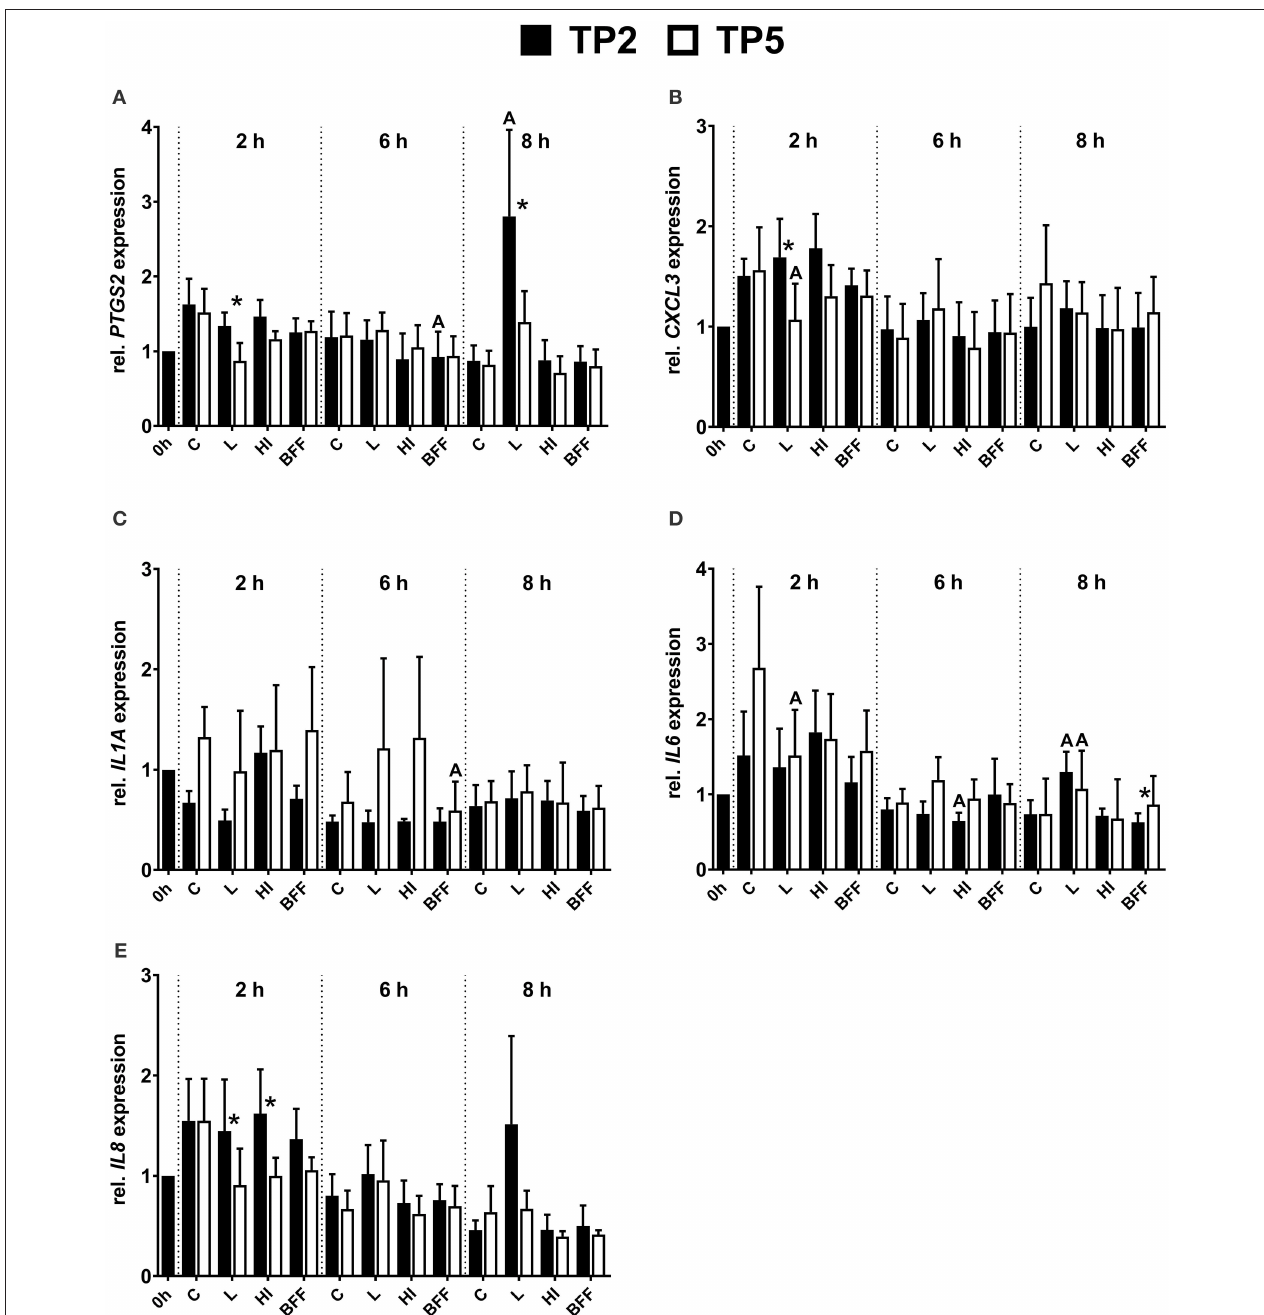
FIGURE 5 | Relative mRNA expression of (A) PTGS2 , (B) CXCL3 , (C) IL1A , (D) IL6 , and (E) IL8 in bovine endometrial epithelial cells co-cultured with TP2 or TP5 at MOI = 1 up to 8 h in the form of live (L), heat-inactivated (HI), or bacteria-free filtrate (BFF). The bars show means ± SEM of mRNA expression values from different cultures ( n = 5 cows). The letters above the bars indicate significantly different mRNA expression ( P < 0.05) compared with the control (C; untreated) at the same time point. Asterisks above the bars indicate significantly different mRNA expression ( P < 0.05) between TP2 and TP5 at the same time point.